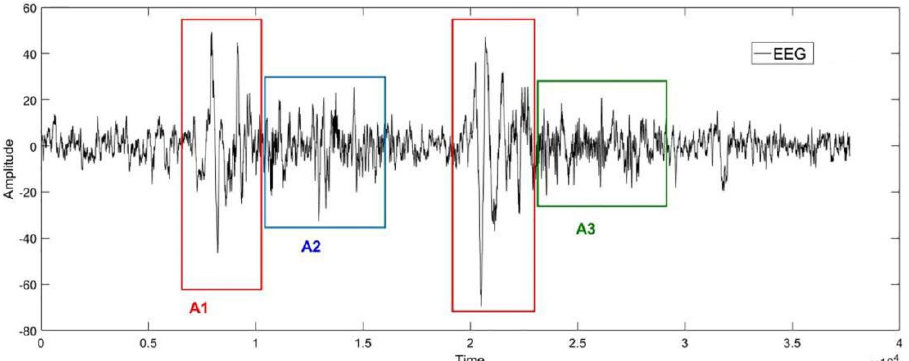
Figure 1. An example of the EEG in cyclic alternating pattern (CAP) in sleep stage 2. The horizontal axis represents the sampling point, and the vertical axis represents the amplitude of the signal. The shapes of the EEG signals in red, blue, and green boxes correspond to the CAP − A1, CAP − A2, and CAP − A3, respectively.